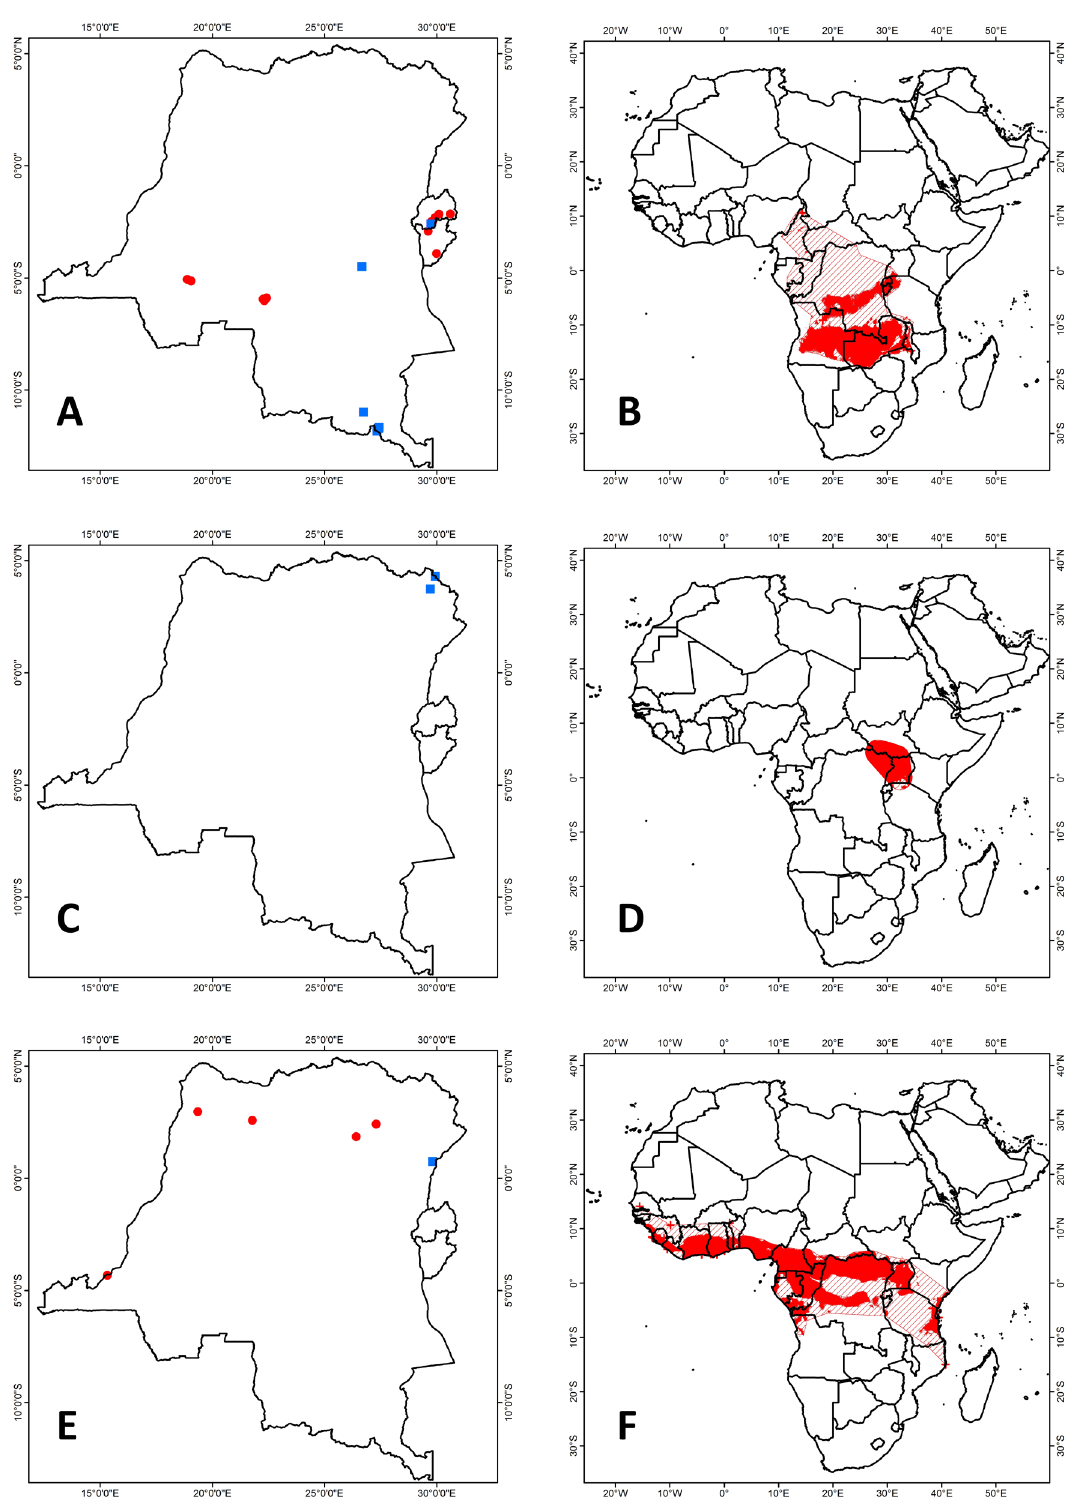
Fig. 29. Distribution maps. A–B . Mops (Mops) niveiventer Cabrera & Ruxton, 1926. C–D . Mops